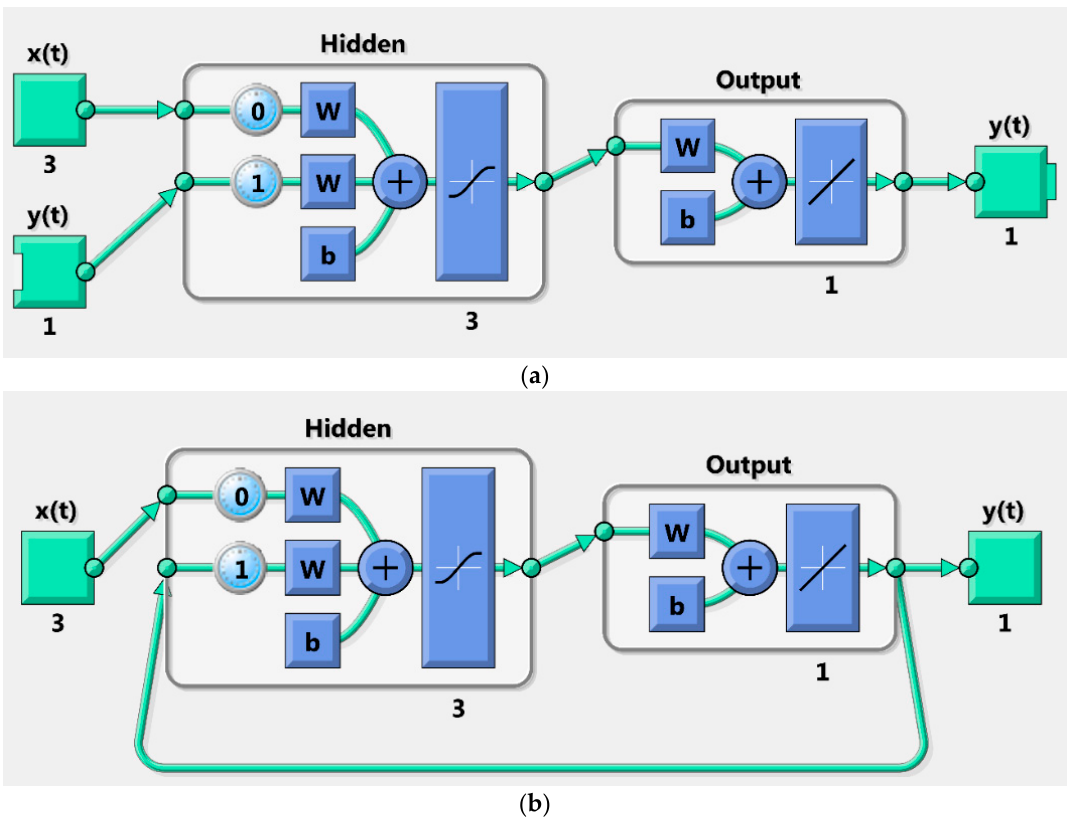
Figure 2. Structure of the neural network model with external inputs (NARX) network where x is the external input, y is the output, w is the weight and b is the bias in: ( a ) Open loop; ( b ) Closed loop.